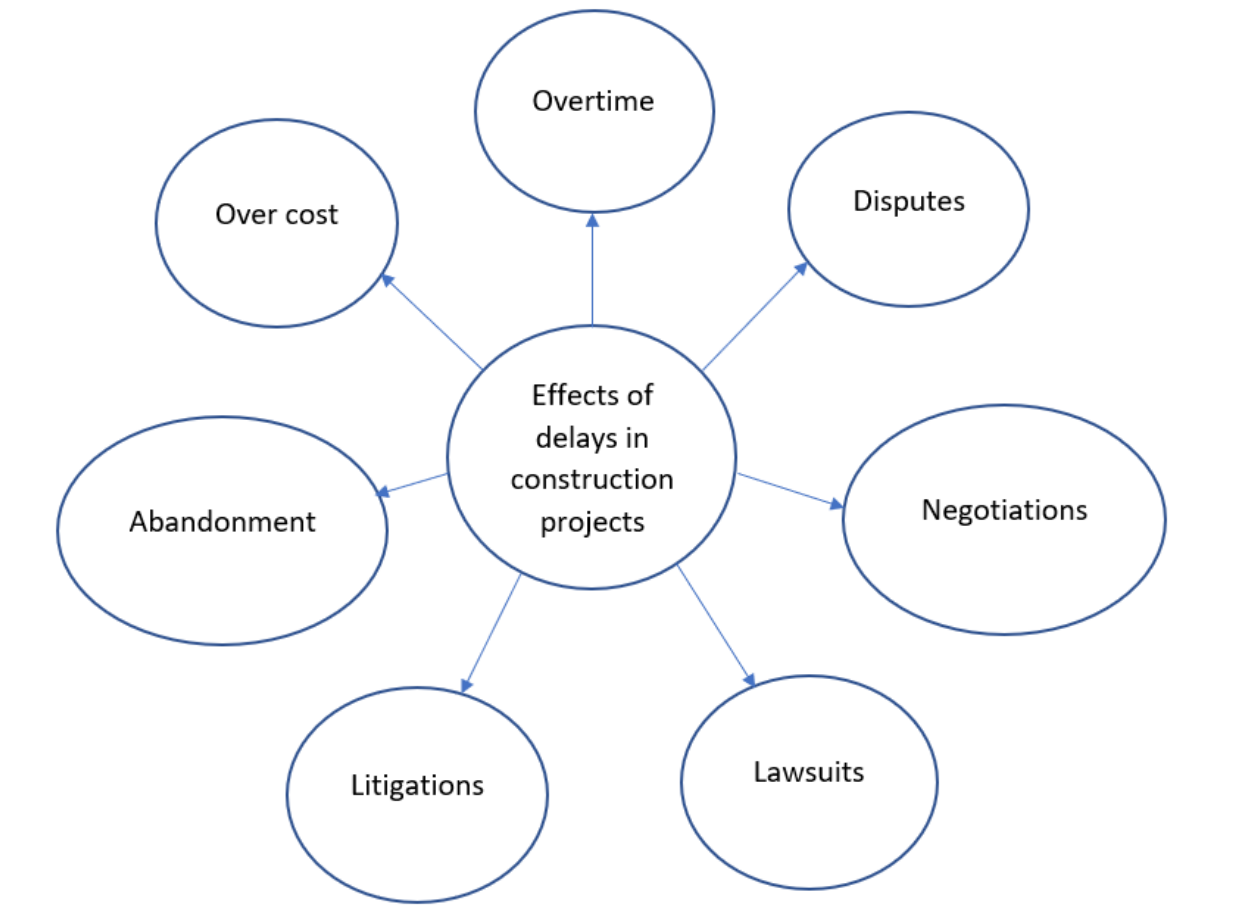
Figure 7. Effect of delays in construction projects.